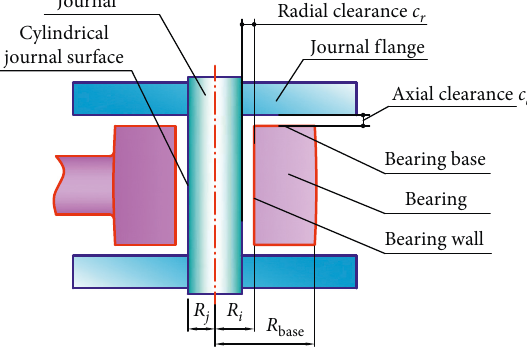
Figure 2: Structure of 3D revolute joint showing clearances.